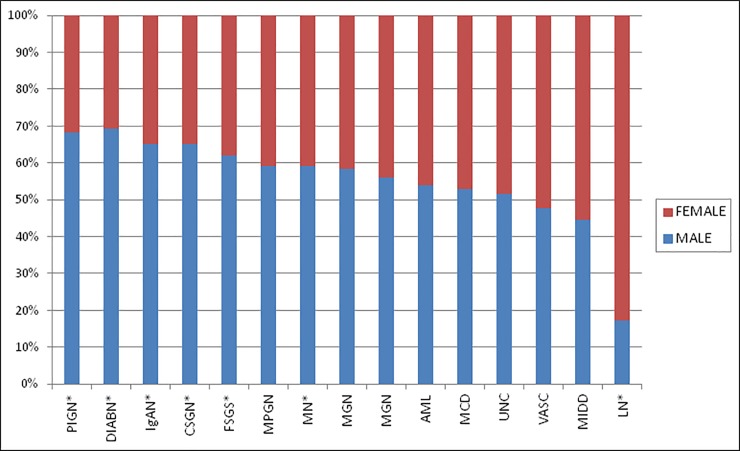
Sex distribution by diagnosis.PIGN Postinfeccious glomerulonephritis; DIABN Diabetic nephropathy; IgAN IgA nephropathy; CSGN Chronic Sclerosing glomerulonephritis; FSGS Focal Segmental Glomerulosclerosis, MPGN Membranoproliferative glomerulonephritis; MN Membranous nephropathy; MGN Mesangial glomerulonephritis (Not IgA); AML Amyloidosis; MCD Minimal Change disease; UNC Unclassifiable; VASC Vasculitis; MIDD Monoclonal immune deposition disease; LN Lupus nephritis. * Significantly different from 50% (p<0.05).